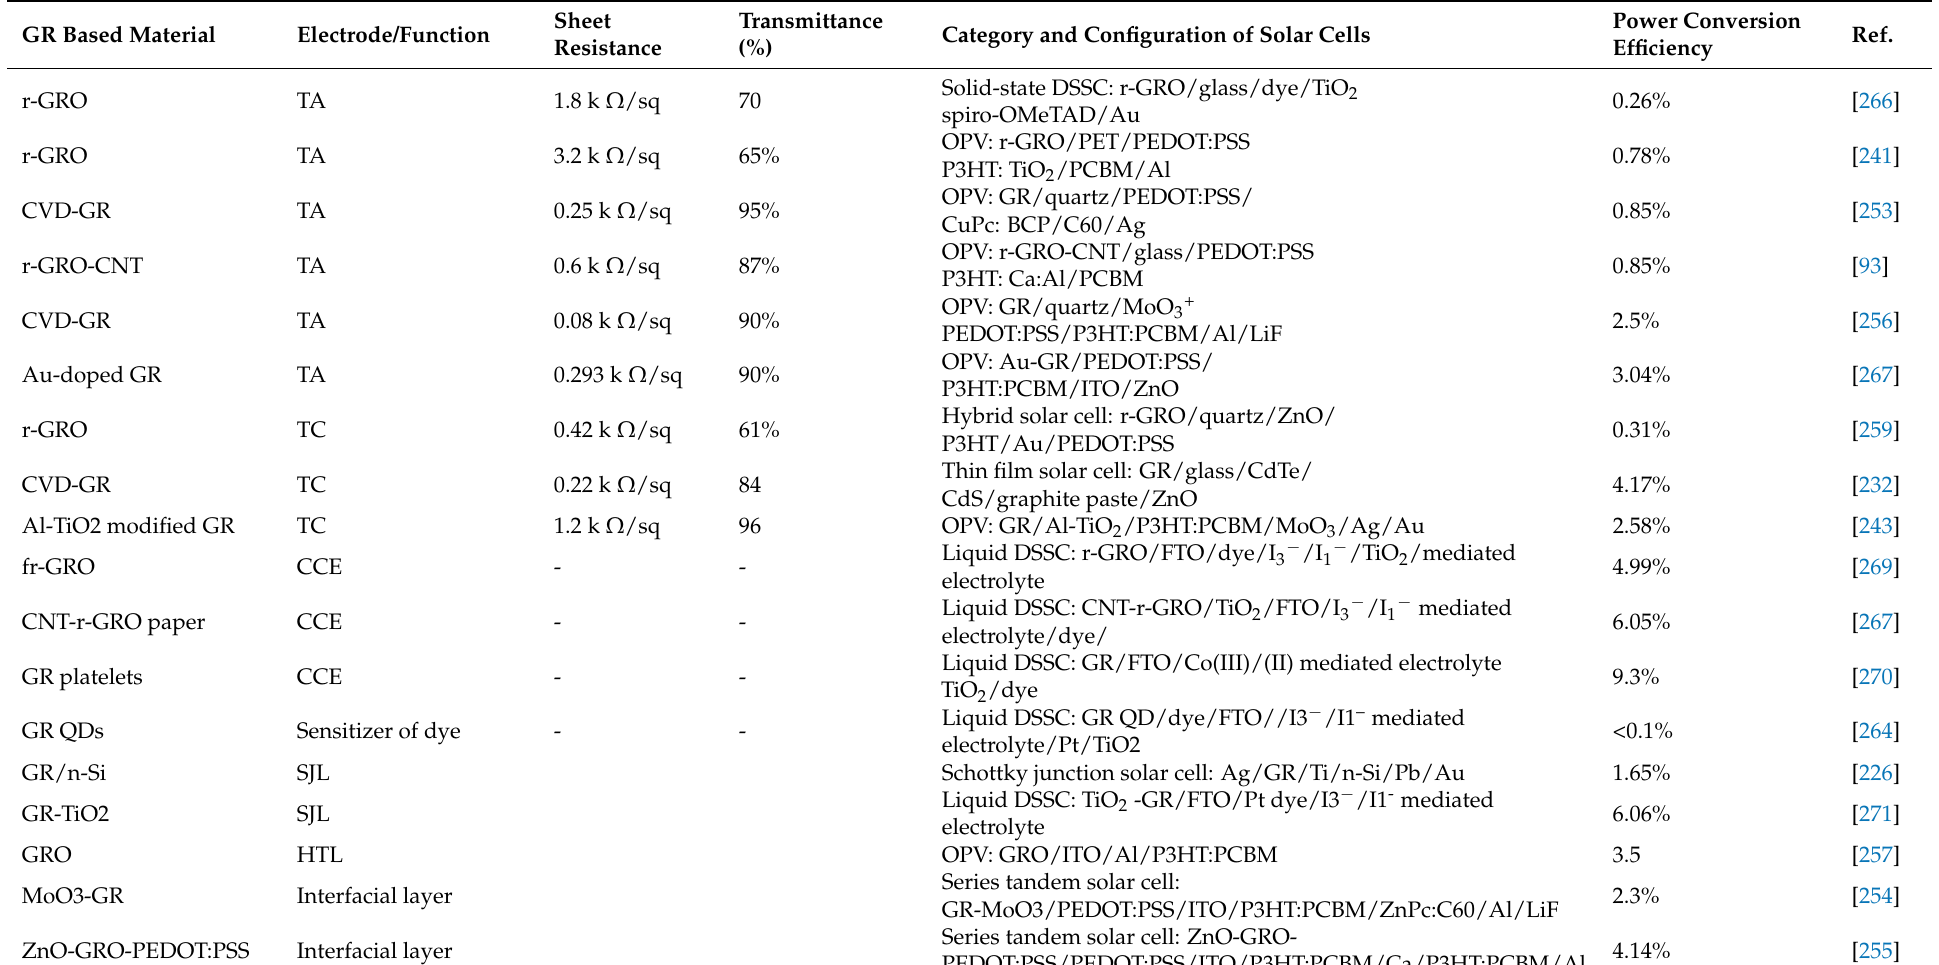
Table 6. Summary of GR and GR-based composites for solar